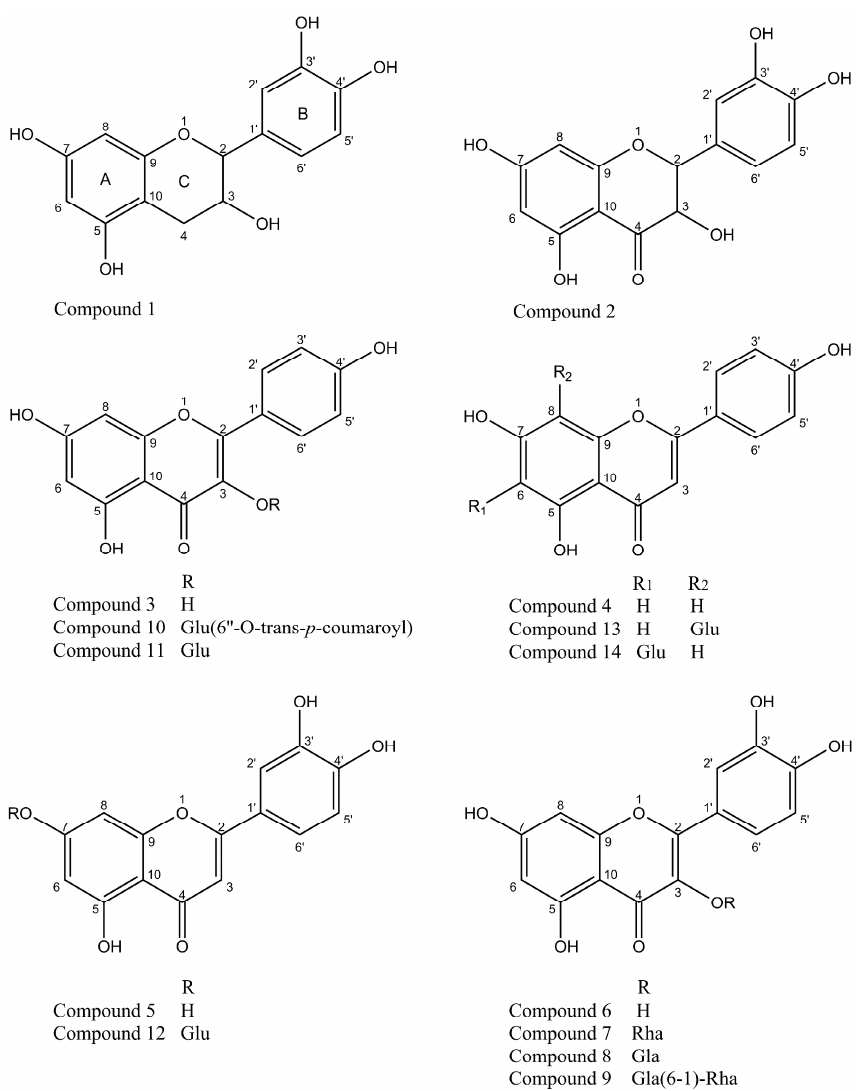
Figure 1. Chemical structures of flavonoids from Agrimonia pilosa Ledeb. 1 . catechin, 2 . taxifolin, 3 . kaempferol, 4 . apigenin, 5 . luteolin, 6 . quercetin, 7 . quercitrin, 8 . hyperoside, 9 . rutin, 10 . tiliroside, 11 . kaempferol-3- O -glucoside 12 . luteolin-7- O - β -glucoside, 13 . vitexin, 14 . isovitexin.